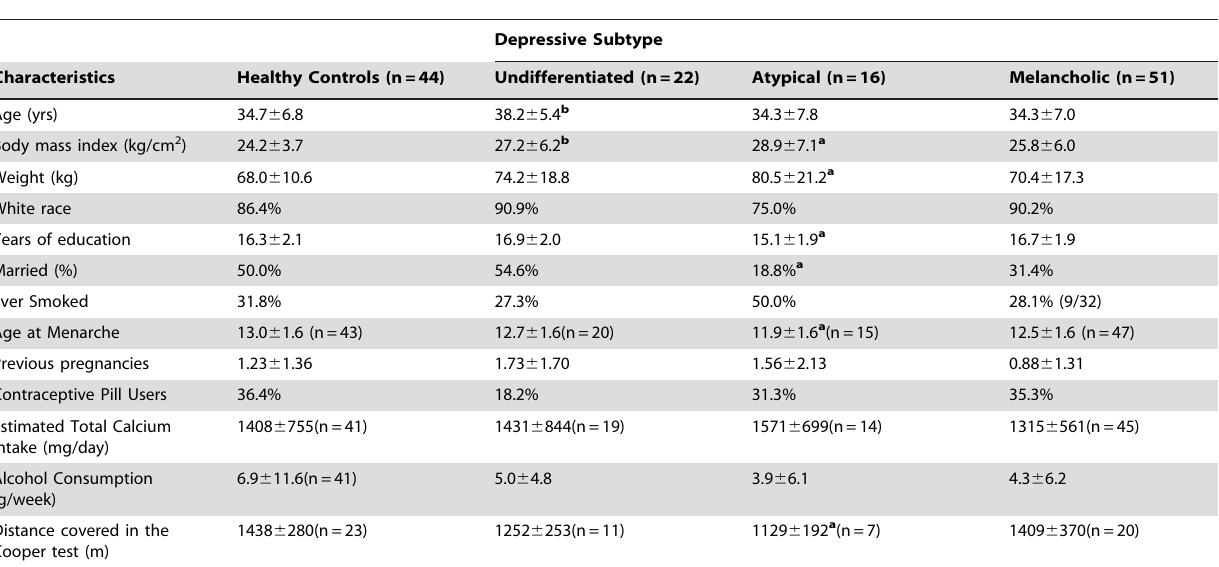
Table 1. Demographic characteristics of depressive subtypes of women with unipolar